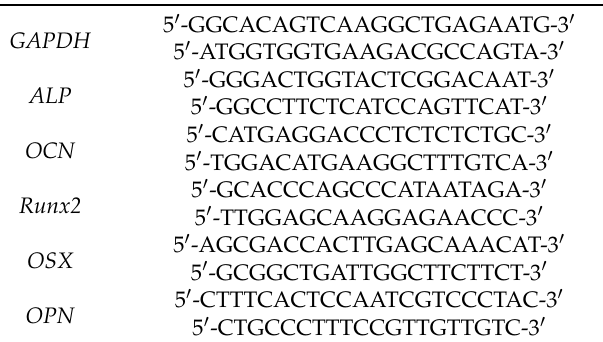
Table 1. Primer sequences